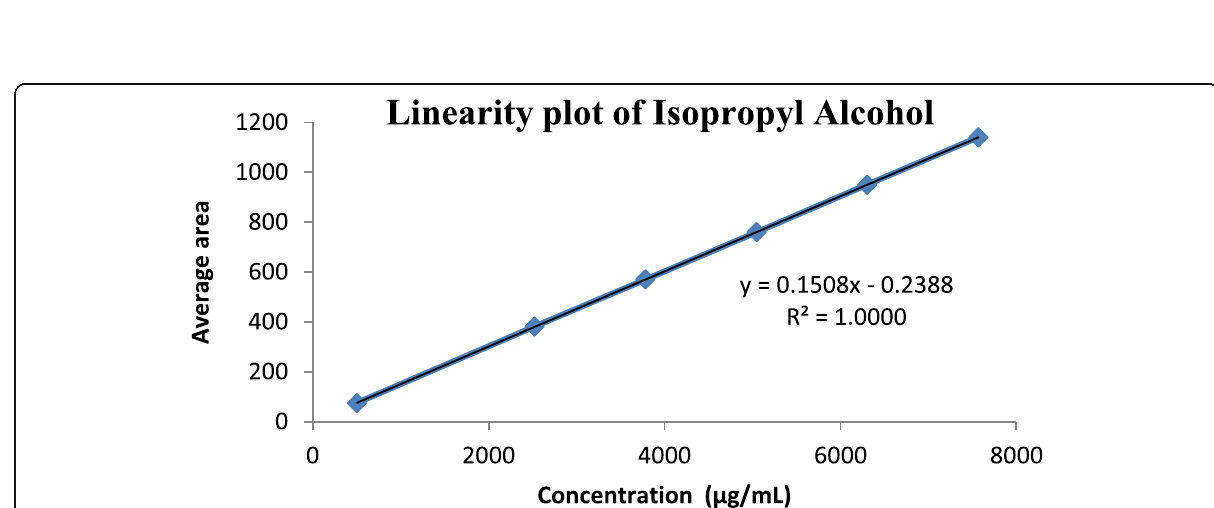
Fig. 7 Linearity plot of Isopropyl Alcohol